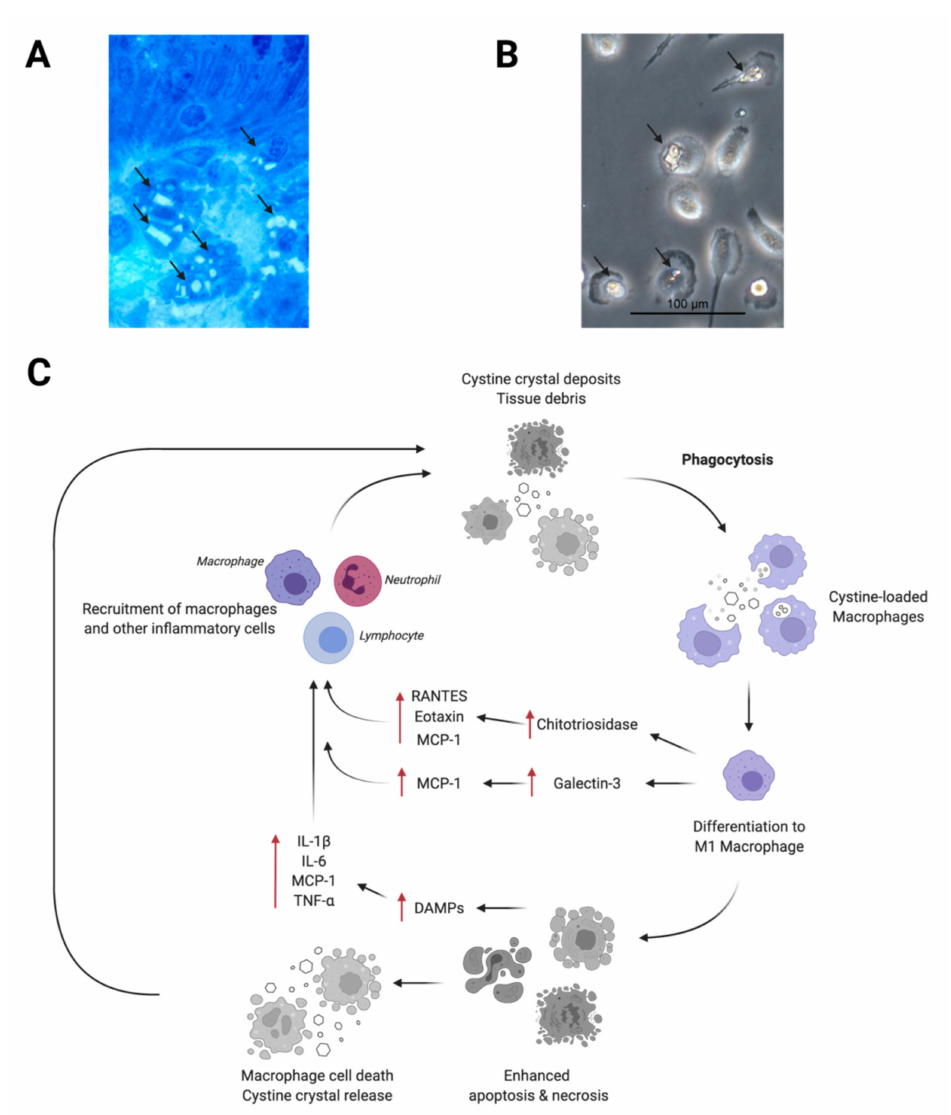
Figure 1. Macrophage activation and tissue injury in cystinosis. ( A ) Tissue cystine crystal accu- mulation in gastric mucosa (Toludine blue). Hexagonal and rhomboid cystine crystals are visible inside interstitial macrophages (arrows). ( B ) In vitro, incubation of macrophages with cystine crystals is followed by phagocytosis of the crystals (arrows). ( C ) A schematic diagram summarizing the mechanisms of macrophage recruitment and injury in tissues of nephropathic cystinosis patients. DAMPs, damage-associated molecular patterns; IL-1 β , interleukin 1 β ; IL-6, interleukin 6; MCP-1, monocyte chemoattractant protein-1; RANTES, Regulated on Activation, Normal T Expressed and Secreted; TNF- α , tumor necrosis factor- α